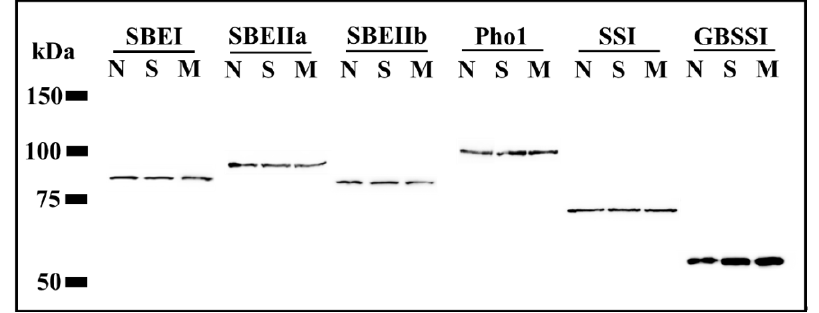
Figure 6. Protein amounts of amylose/amylopectin synthesis key enzymes in starches from non-shrunken (N), slightly shrunken (S), and moderately shrunken seeds (M). The protein amount is standardized by milligrams of